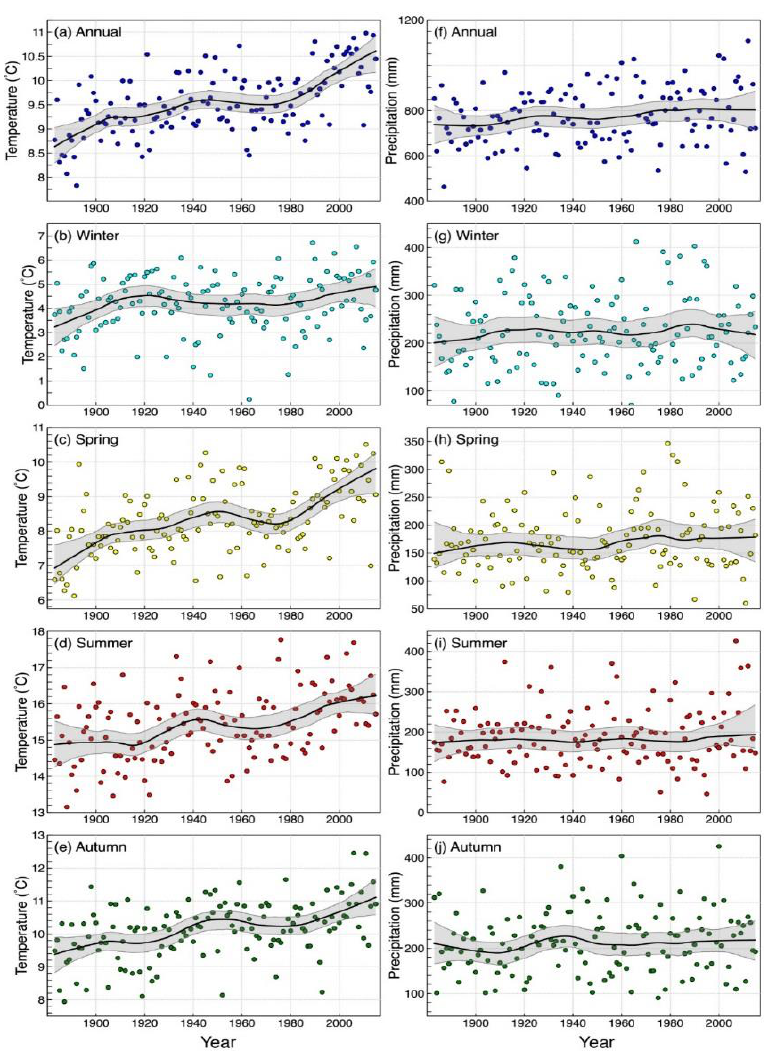
Figure 3. The seasonal and annual evolution of ( a – e ) mean temperature and ( f – j ) total precipitation from WP, 1883–2015. Locally-weighted regression trends ( n /2 smoothing parameter) with 95% confidence intervals are plotted for each panel.